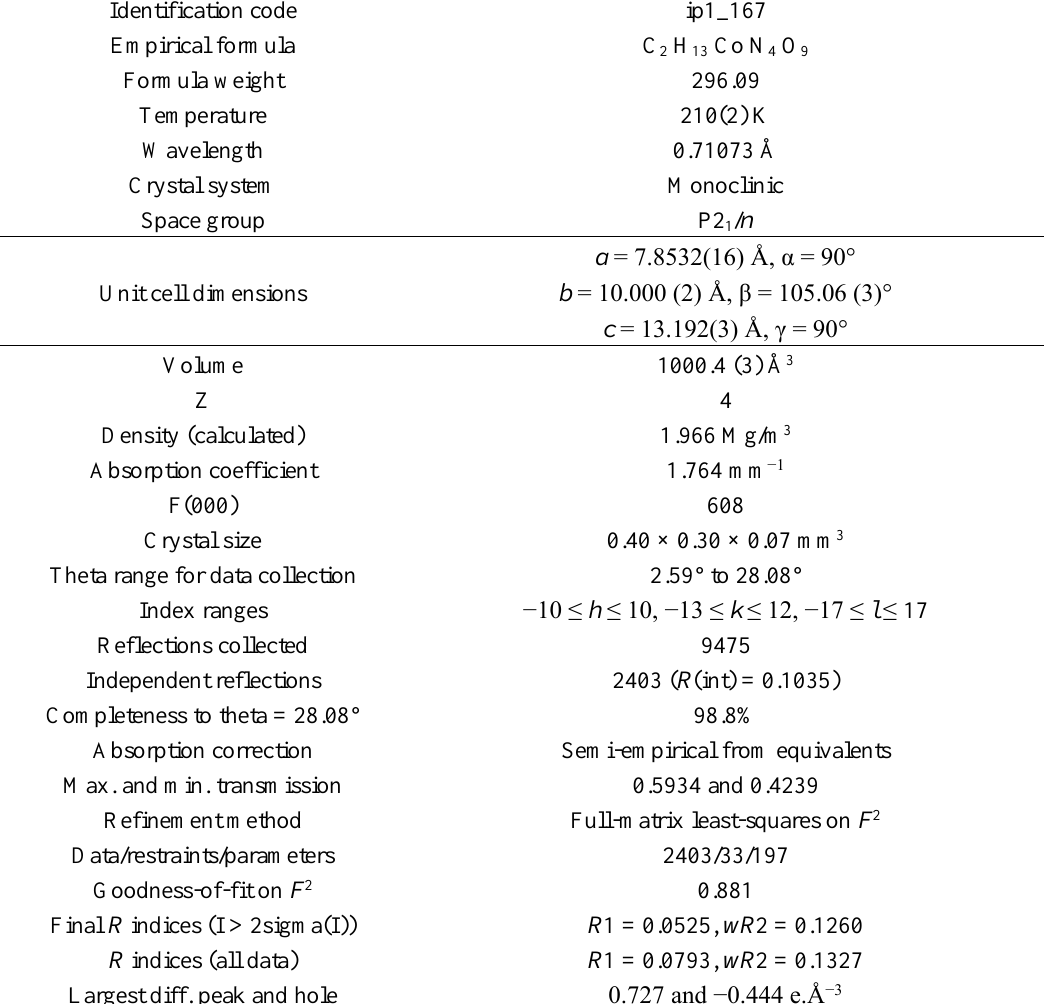
Table 1. Crystal data and structure refinement for fac -[Co(NH 3 ) 3 (C 2 O 4 )(H 2 O)]NO 3 ·H 2 O ( 2